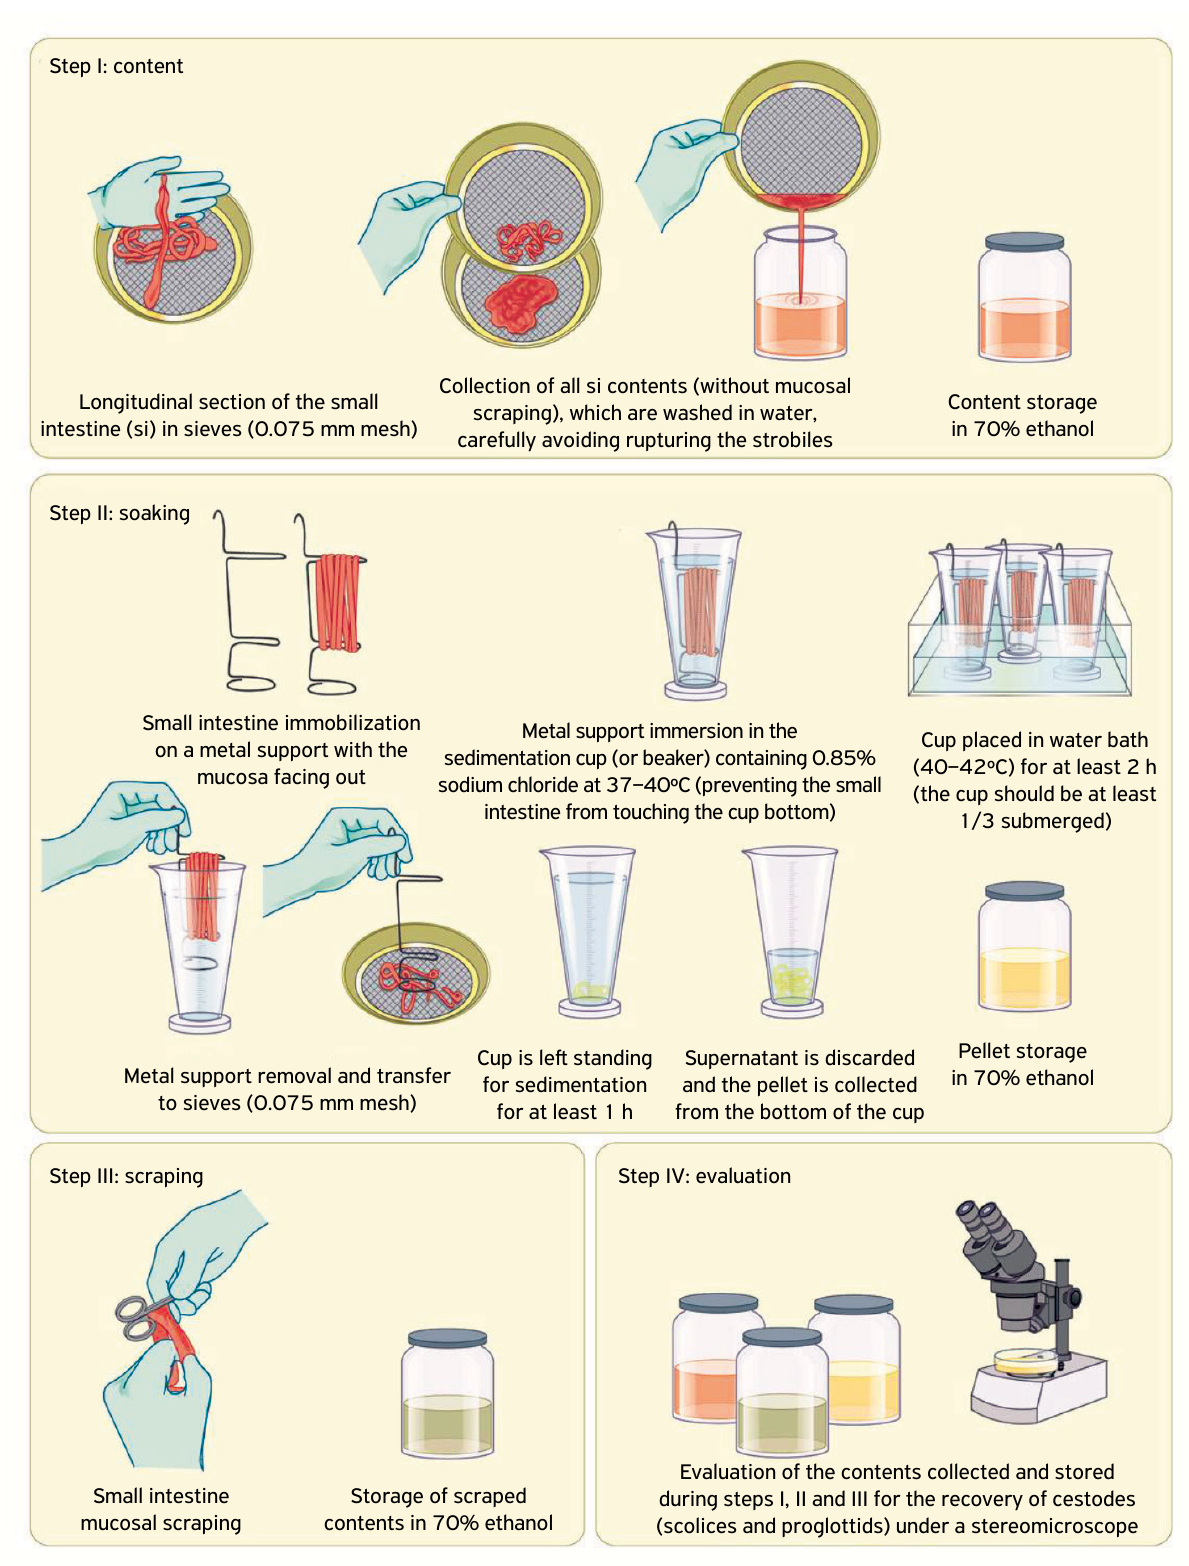
Figure 1. Mello and Campos method steps applied to recover cestode parasites from birds ( Gallus domesticus